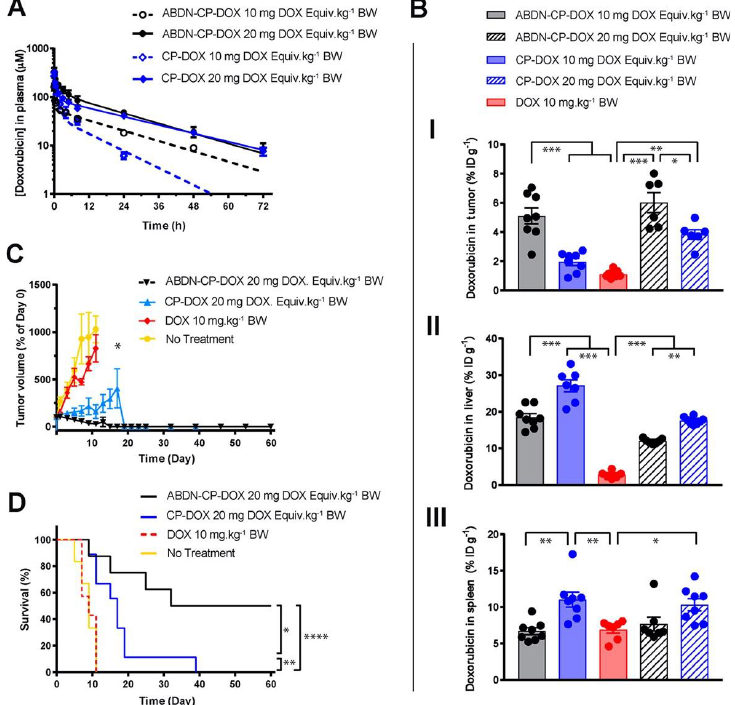
Figure 3. Role of dosing on nanoparticle drug efficacy. An albumin binding nanoparticle of doxo- rubicin (ABDN-CP-DOX) was compared head-to-head with a non-albumin binding counterpart (CP-DOX). ( A ) pharmacokinetic profile of the nanoparticles at different doses in mice. ( B ) Biodistri- bution of the doxorubicin conjugated to various nanoparticles at 24 h post-administration in the (I) tumor, (II) liver, and (III) spleen. All nanoparticles show better tumor accumulation and less liver accumulation at the higher dose. ( C ) Tumor regression curve in an s.c. mouse C26 colon cancer model, up to day 60. ( D ) cumulative survival of tumor-bearing mice treated with indicated drugs. * for p < 0.05, ** for p < 0.01, *** for p < 0.001, and **** for p < 0.0001. Reprinted (adapted) with permis- sion from [56]. Copyright 2018 American Chemical Society.